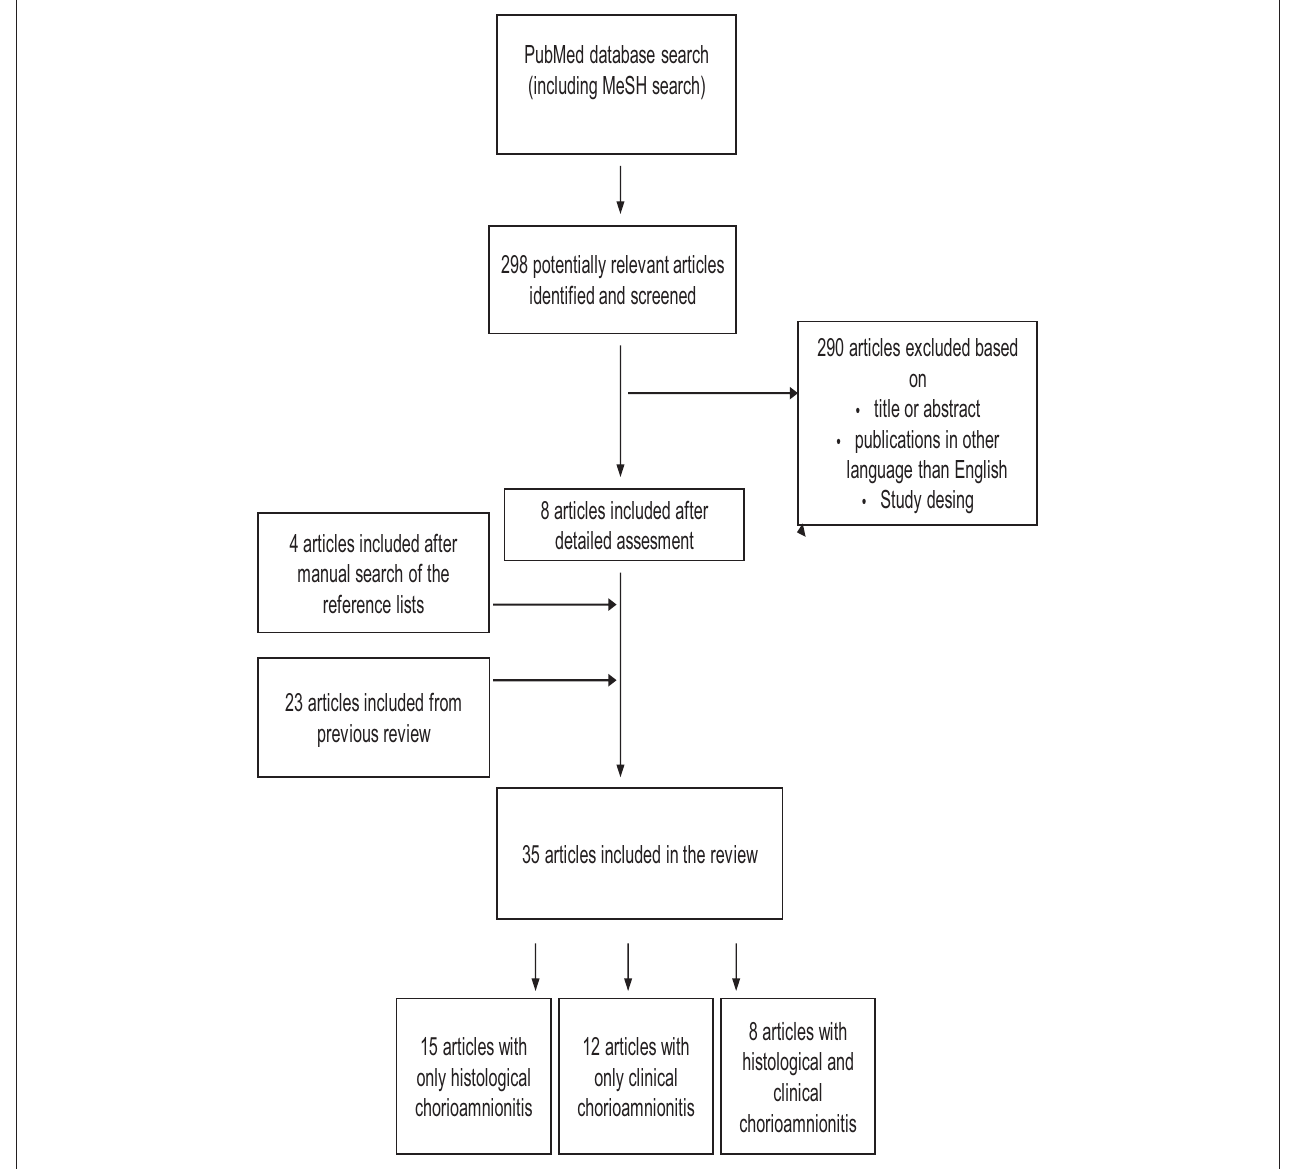
FIGURE 1 | Study selection process for articles about the association between chorioamnionitis and cognitive and neuropsychological outcome in preterm infants. The search was performed for articles published between October 5, 2011and September 12, 2018. Articles published before October 5, 2011 was identified earlier as a part of our previous